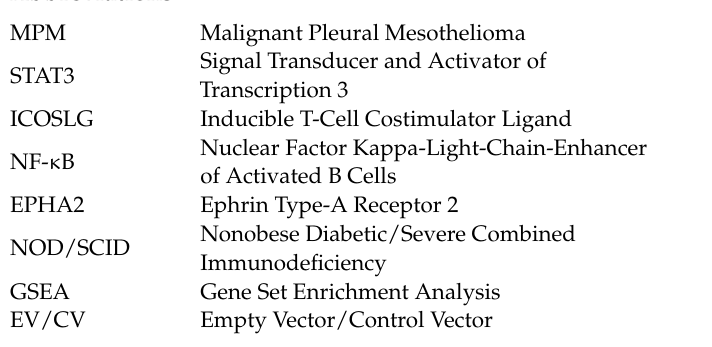
and napabucasin; Figure S7: Targeting the STAT3 pathway in preclinical models of MPM; Figure S8: GSEA pathways downregulated by atovaquone and pyrimethamine; Figure S9: GSEA path- ways upregulated by atovaquone and pyrimethamine; Figure S10: Atovaquone and pyrimethamine regulate the expression of STAT3 target genes; Table S1: Patient information; Table S2: IC 50 values for STAT3pathway inhibitors; Table S3: Tumor (MS4)-atovaquone; Table S4: H28-pyrimethamine; Table S5: H28-atovaquone; Table S6: MSTO-pyrimethamine; Table S7: MSTO-atovaquone; Table S8: Common up- and downregulated GSEA pathways; Table S9: